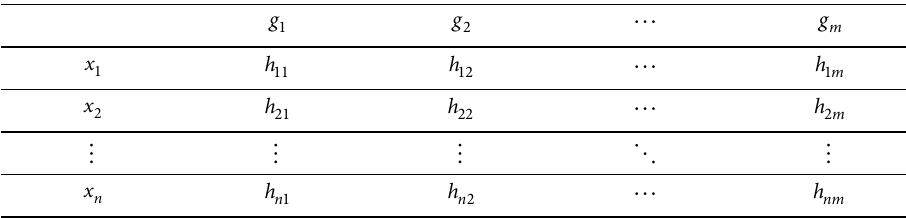
Table 1. The hesitant fuzzy decision matrix